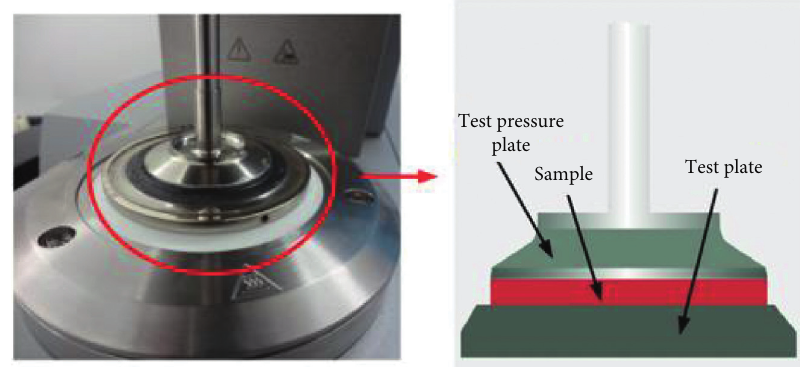
Figure 1: MCR 302 rotating rheometer and test module.